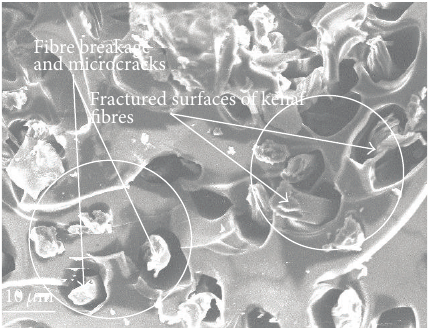
Figure 17: SEM micrograph shows microcracks and fibre